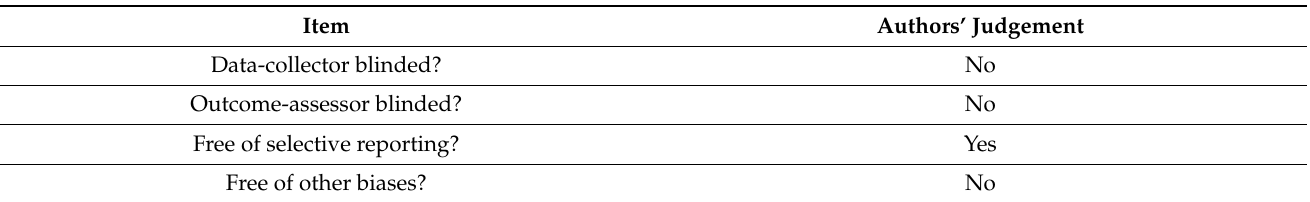
Table A6. Risk of